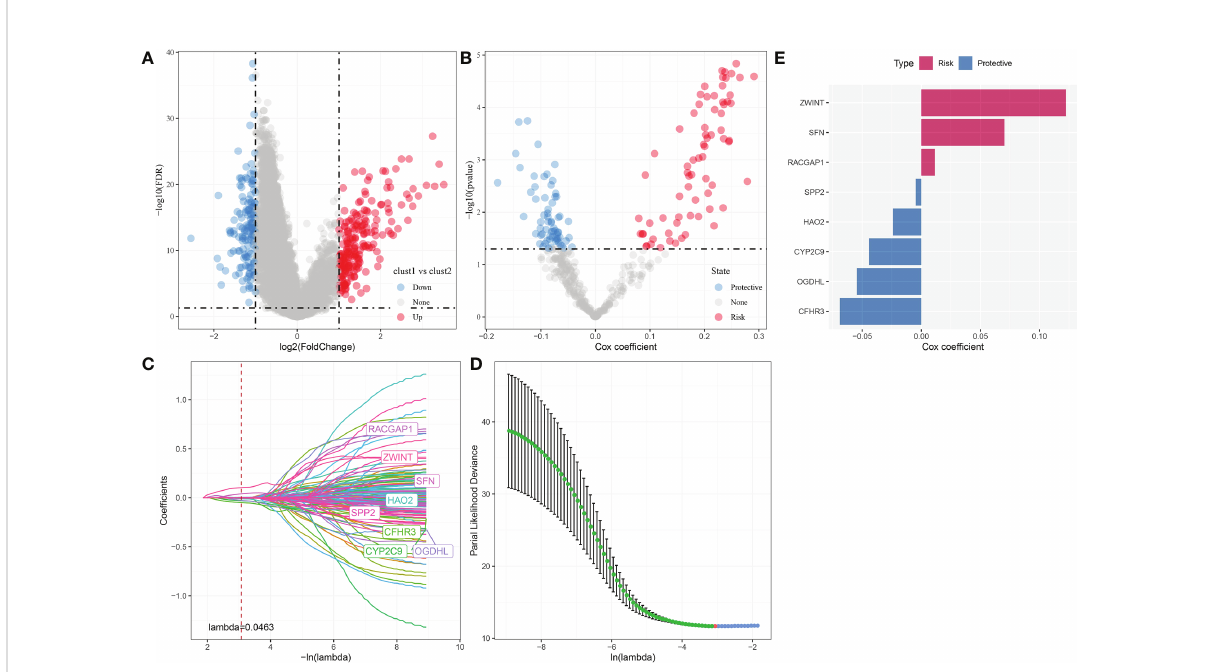
FIGURE 8 Identi fi cation hub autophagy-related genes. (A) Volcano plot of differentially expressed genes identi fi ed from autophagy-related pathways between Clust1 vs . Clust2. (B) Volcano plot of differentially expressed genes identi fi ed using univariate Cox analysis. (C) Lambda trajectory of differentially expressed genes. (D) Con fi dence interval under lambda. (E) Eight hub genes, including three risk genes and fi ve protective genes, were obtained.